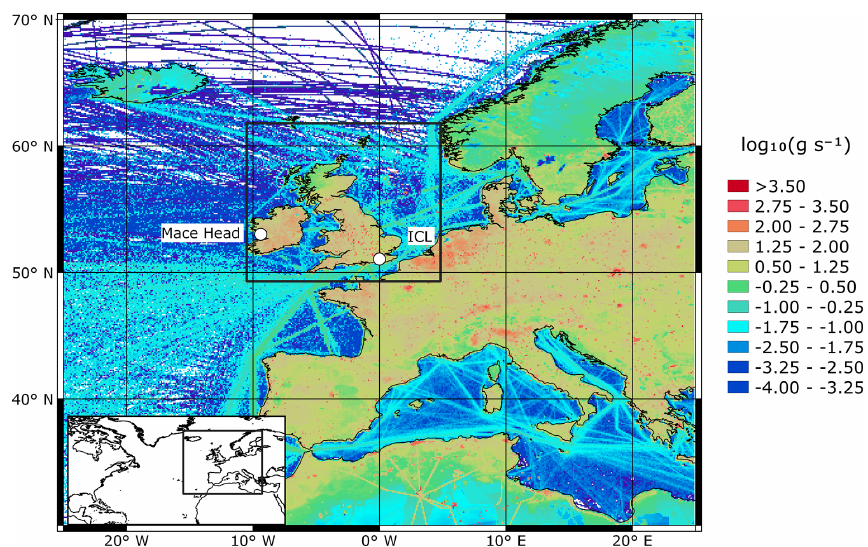
Figure 2. The NAME footprint modelling domains. The inset map denotes the area encompassed by the 25km footprints. The black box denotes the domain of the 10km footprints, which is shown in the main frame along with the 0 . 1 ◦ × 0 . 1 ◦ EDGAR v4.3.2 emissions. The black box surrounding the British Isles denotes the 2km footprint domain. Table 1. NAME model parameters used for each set of footprints. Footprint Horizontal